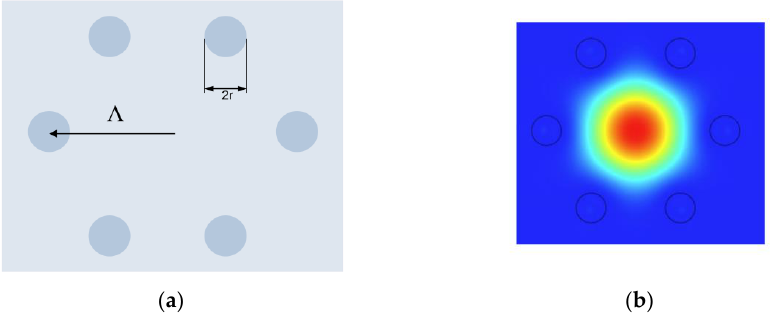
Figure 3. ( a ) Cross-section of an ASBGF and an HF with one row of the cladding holes and rods in the cladding; ( b ) fundamental core mode of an ASBGF.